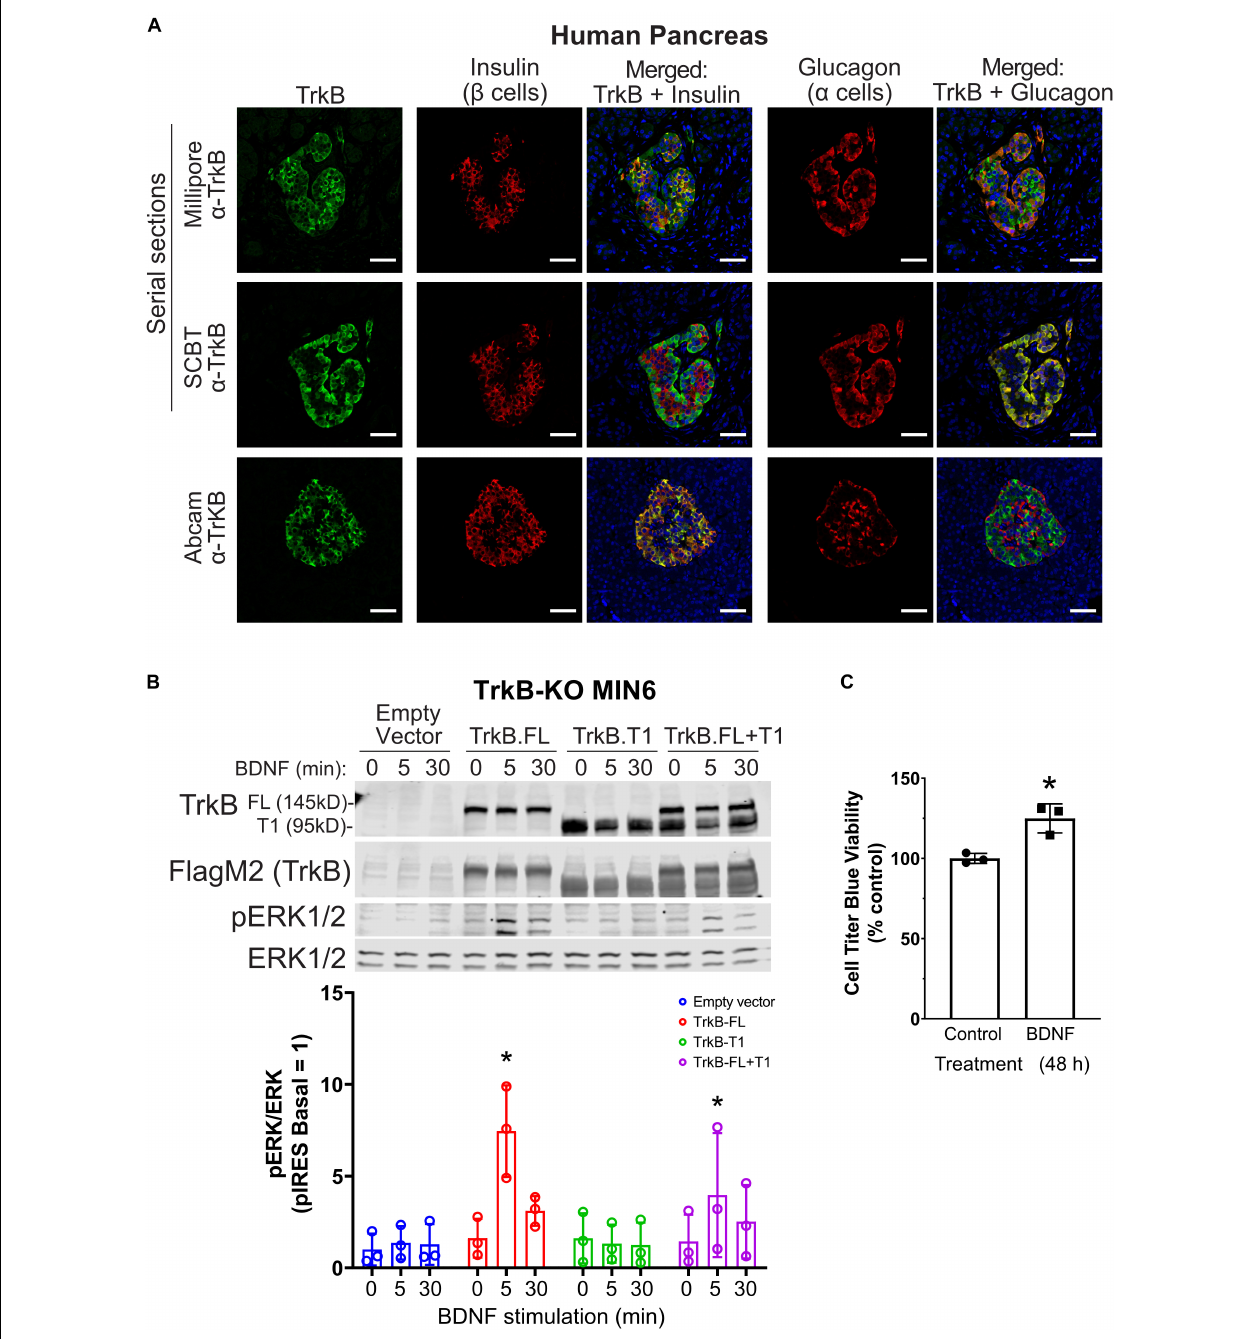
FIGURE 2 | TrkB is expressed in pancreatic islets and chronic BDNF signaling promotes insulin secretion and β cell growth. (A) Human pancreas tissue sections were immunostained with antibodies against TrkB (shown in green), insulin to stain β cells (shown in red), glucagon to stain α cells (shown in red), and DAPI to stain nuclei (shown in blue). For the example shown of Millipore and Santa Cruz anti-TrkB antibody staining, serial sections from the same tissue block were stained with different TrkB antibodies and the same islet was located for imaging. Separate panels are shown to illustrate the overlap of TrkB with β cells (insulin) and TrkB with α cells (glucagon). Overlapping regions of green TrkB staining and red insulin/glucagon staining show up yellow. Data are representative of imaging from 2 human pancreas tissue donors. Scale bar, 50 µ m. (B) To confirm that TrkB-FL is indeed the BDNF receptor signaling to ERK1/2 in β cells, TrkB KO MIN6 cells were transfected with plasmids expressing full-length TrkB (TrkB-FL), TrkB-T1, both, or empty vector (pIRES-3xFlag-dsRed). After 48 h cells were preincubated in KRBH with 4.5 mM glucose for 2 h and stimulated with 10 ng/ml BDNF for 5 and 30 min. Data are the mean ± SD of three independent experiments. * P < 0.05 for 0 vs 5 min of BDNF stimulation by two-way ANOVA using Dunnett’s multiple-comparison test. (C) To assess pro-growth effects of chronic BDNF stimulation, MIN6 cells plated in 96-well dishes were incubated for 48 h with BDNF (100 ng/ml) followed by Cell Titer Blue assay for viability. Bar graph is the mean ± SD from three independent passages of cells. * P < 0.05 Control vs. BDNF by Student’s t -test.